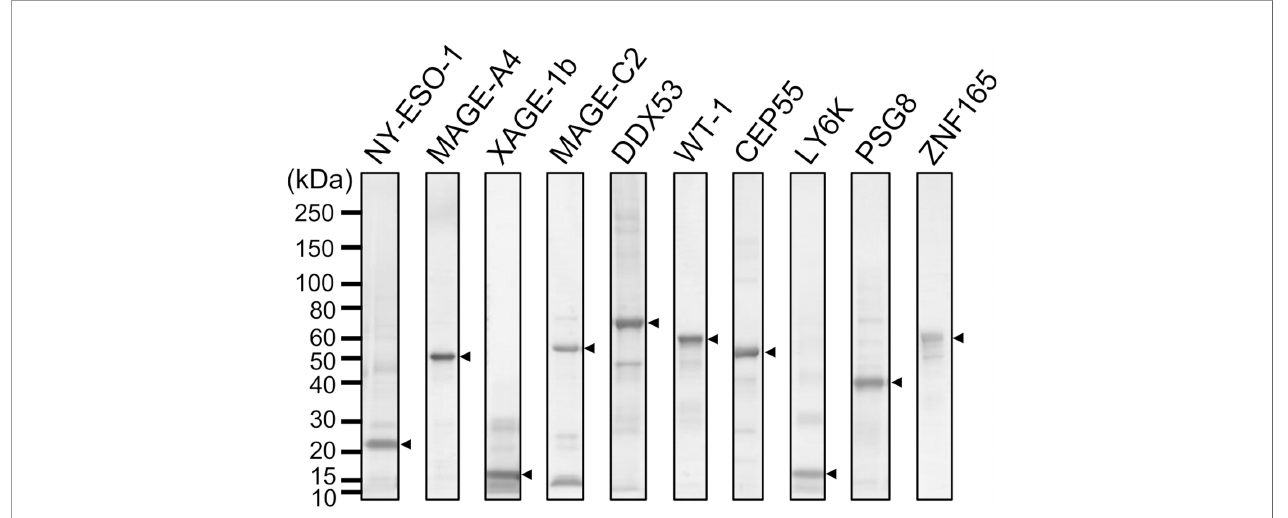
FIGURE 2 | SDS-PAGE analysis of antigens employed for MUSCAT